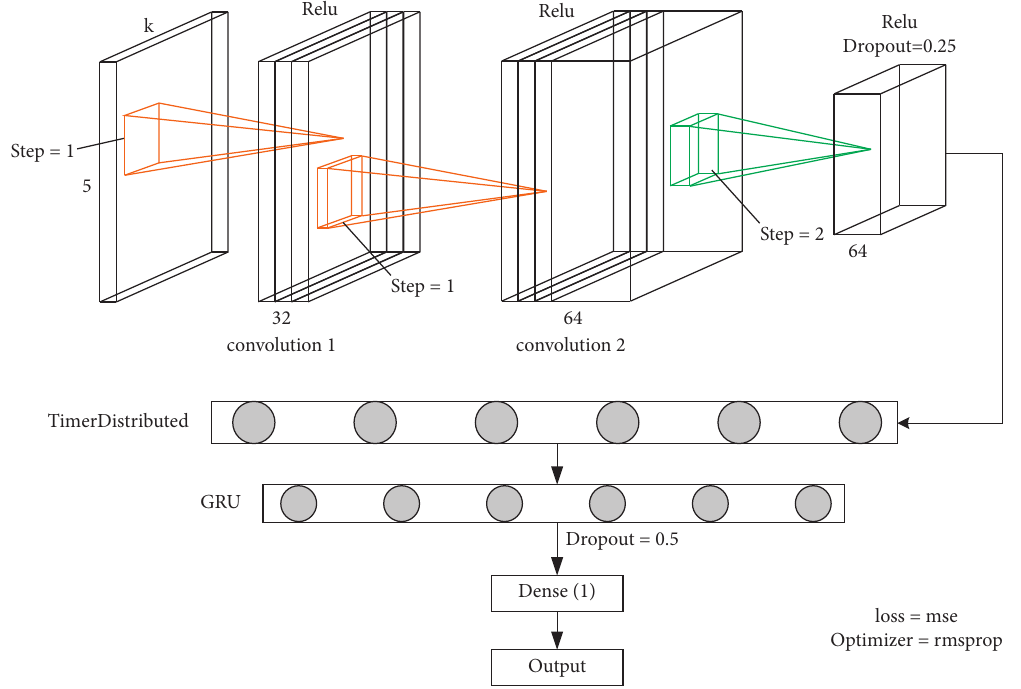
Figure 5: The overview of